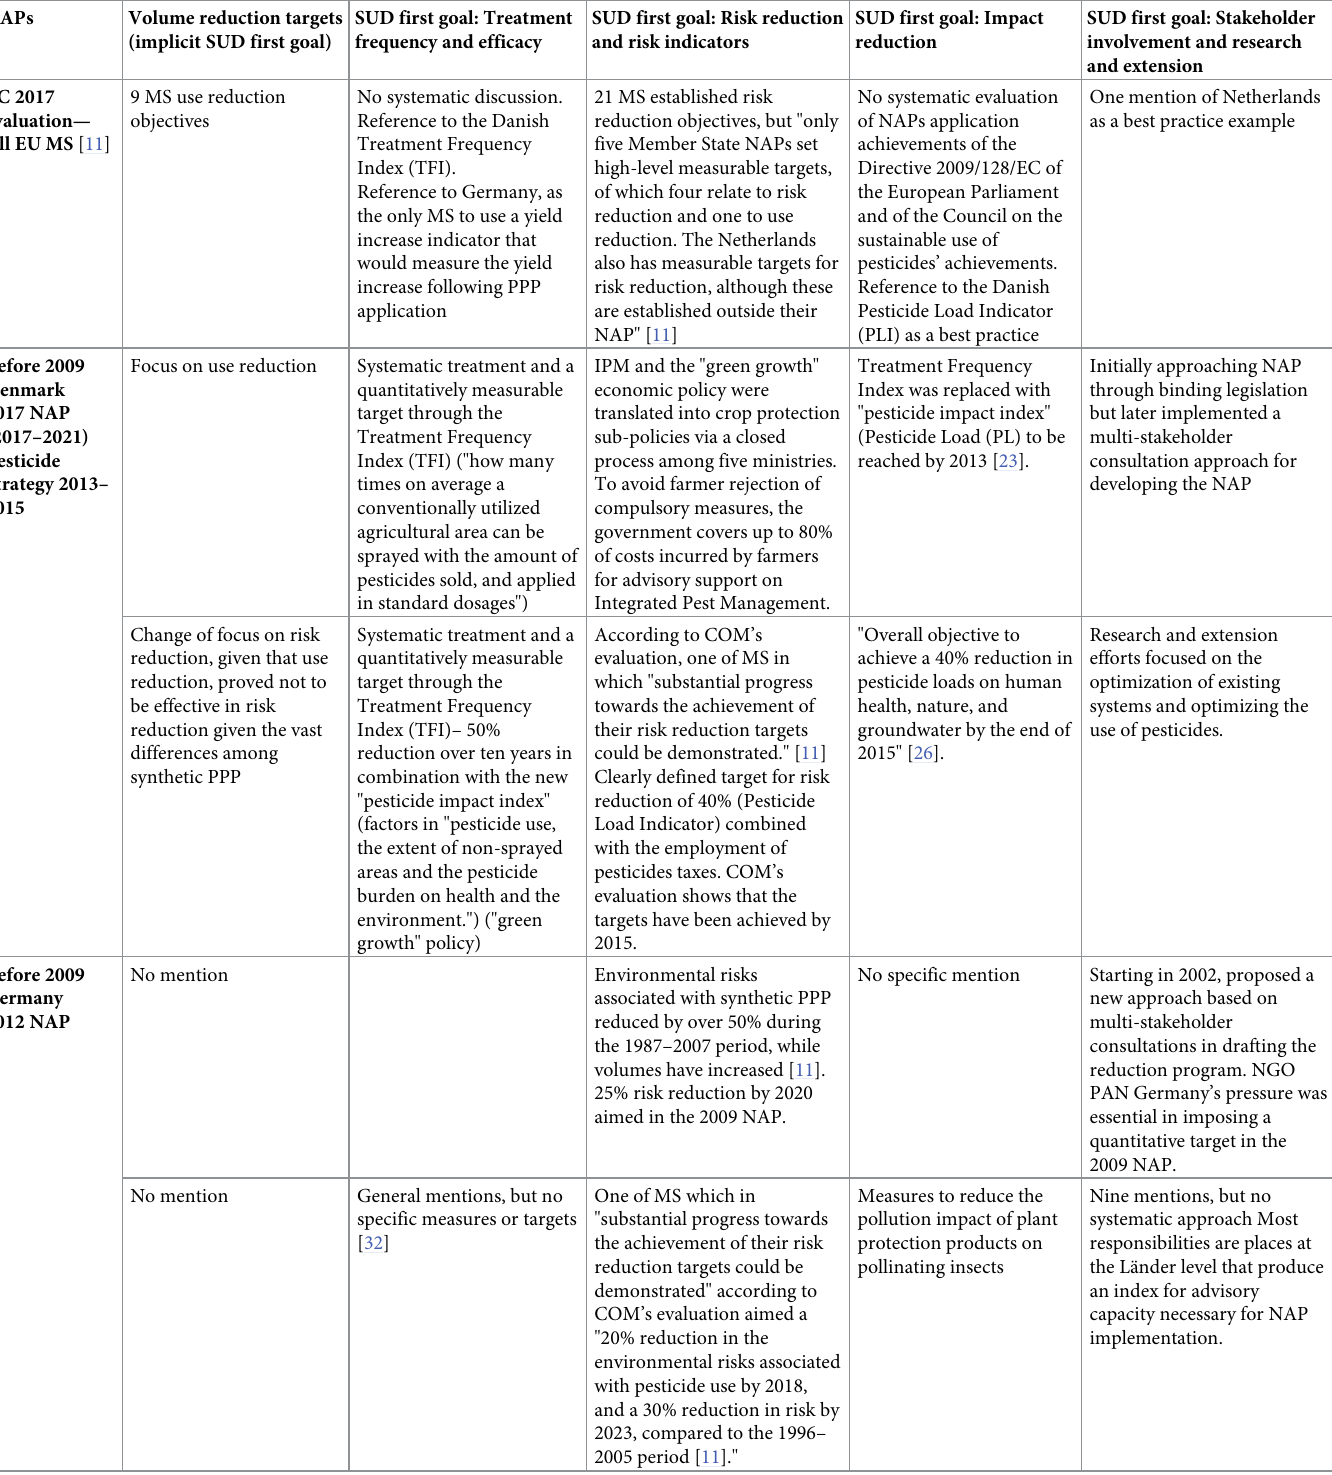
Table 1. A comparative survey of EU comprehensive analysis, and the National Action Plans of Denmark, Germany, the Netherlands, France, the UK, Romania, Hungary, and Poland along the following dimensions: Volume reduction targets, treatment frequency and efficacy, risk reduction, impact reduction, stakeholder involvement, and research and